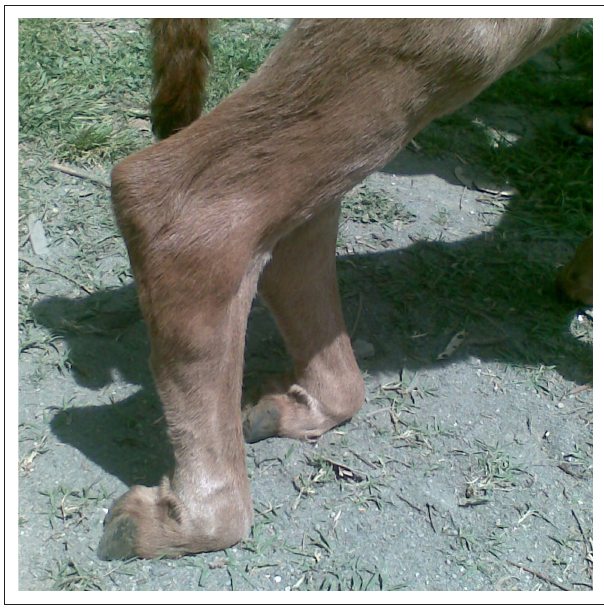
FIGURE 2: Photograph of a neonatal calf with moderate fetlock knuckling of the